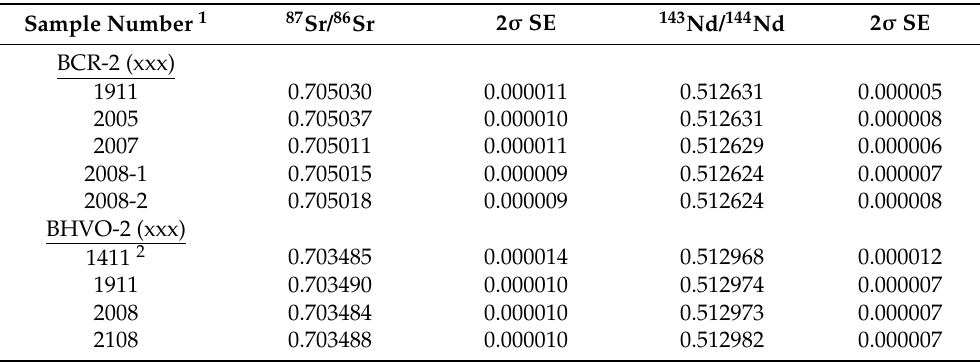
Figure 3. Comparison between the measured and certified ratios of 87 Sr/ 86 Sr ( a ) and 143 Nd/ 144 Nd ( b ) of rock CRMs. To calculate the average, the Sr and Nd isotopic compositions of CRMs were taken from the GeoReM database. Relative deviation (%) = (1—measured value/certified value) × 100%. Table 5. Sr–Nd isotopic compositions of rock